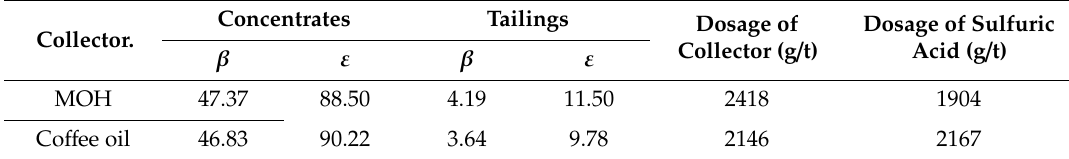
Table 4. Experiment results of closed-circuit tests on ilmenite using MOH and co ff ee oil as collectors.